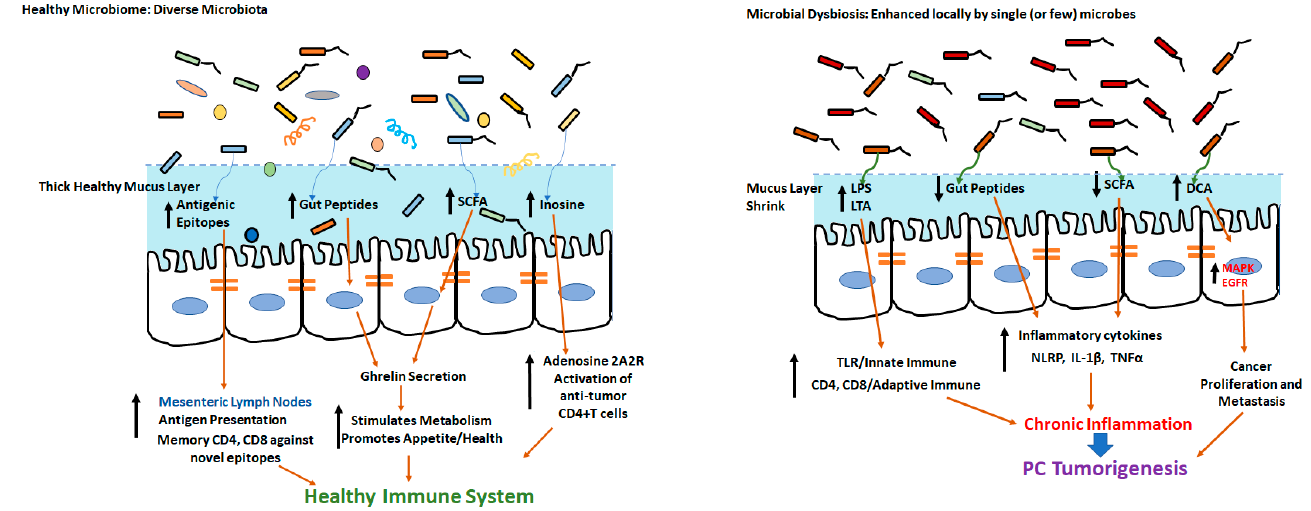
Figure 1. In the presence of healthy microbiome with diverse microbes, the gut epithelium has thick intact mucus membrane and promotes immune health through diverse antigenic epitopes and development of novel memory CD4 and CD8+T cells. Microbial dysbiosis and colonization of single (or a few) harmful microbes could lead to ablation of mucous membrane and release of deleterious metabolites leading to